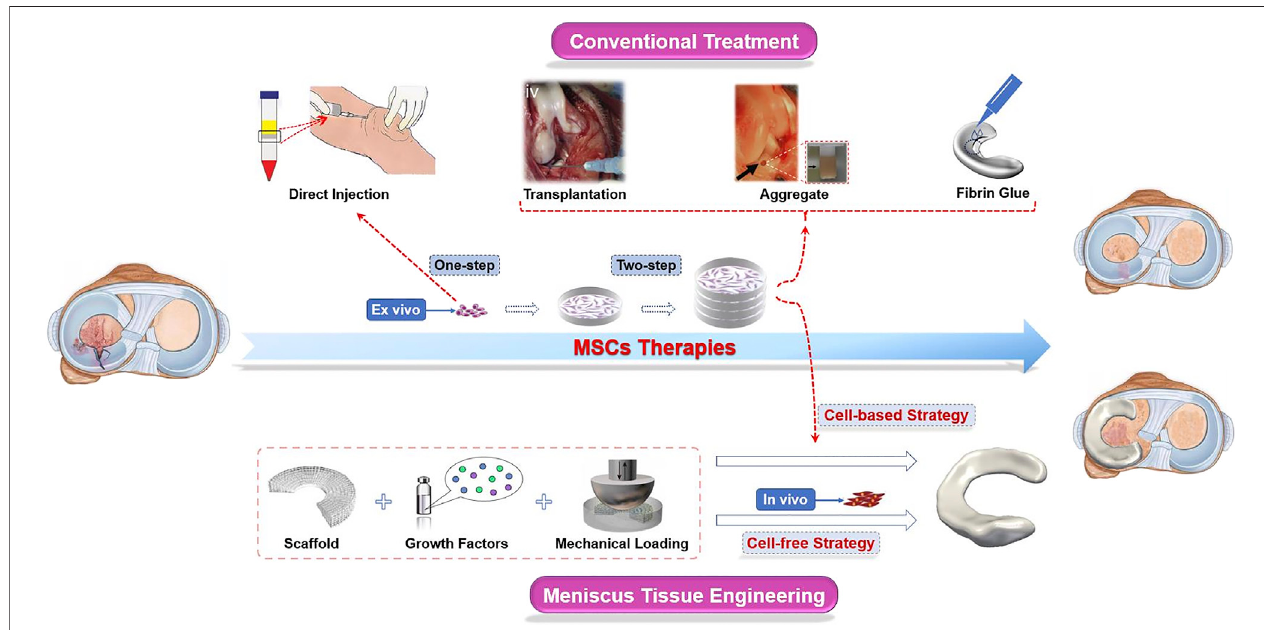
FIGURE 2 | Schematic diagram of MSC therapies used in meniscus regeneration. In conventional approaches, MSCs are transplanted into the knee joints after separation (one-step) and/or culturing (two-step) ex vivo . Cells, scaffolds, and stimuli such as biochemical factors and biomechanical loading are indispensable components inthenovelmeniscustissue engineering(MTE)strategy. ScaffoldsareseededwithMSCsampli fi cated exvivo beforebeing implanted intothekneejointsis a “ cell-based ” strategy, while the “ cell-free ” strategy is aimed at repairing the meniscus by recruiting endogenous MSCs. These images were reproduced with permission (Horie et al., 2012b; Nakagawa et al., 2015; Toratani et al., 2017a; Tarafder et al., 2018; Zhang et al.,